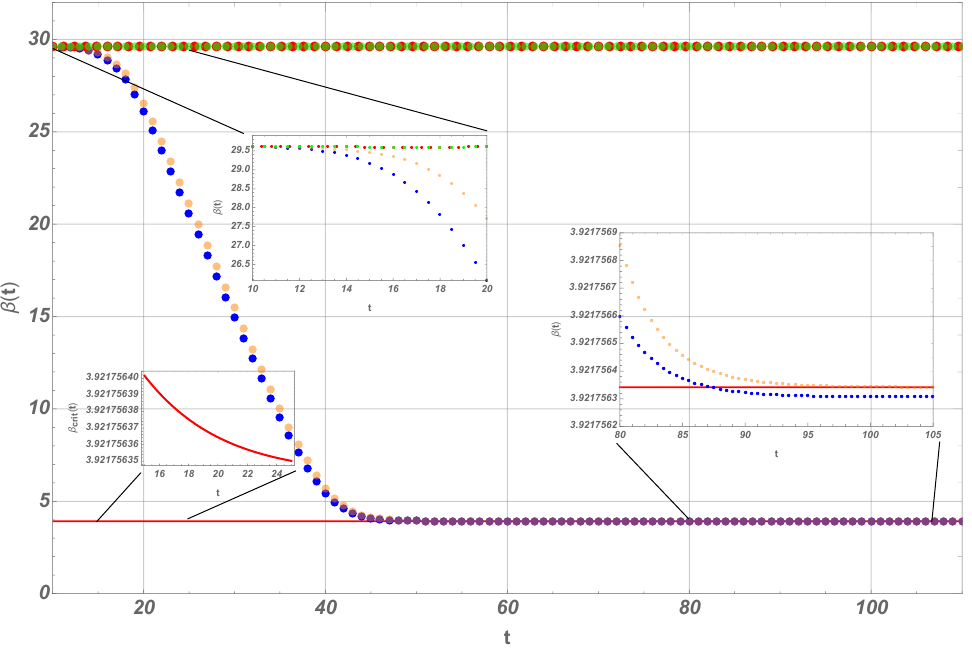
Figure 3 . Plot of e(cid:11)ective temperature as a function of time for various tanh quench pro(cid:12)les. We have chosen, (cid:3) = 3, g i = 1 : 1, (cid:14)t = 10. The blue, orange, red and green corresponds to choosing g f = f 1 : 1+10 (cid:0) 7 : 16 ; 1 : 1+10 (cid:0) 7 : 172 ; 1 : 1+10 (cid:0) 7 : 184 ; 1 : 1+10 (cid:0) 7 : 188 g , respectively. The insets are zoomed in views of di(cid:11)erent